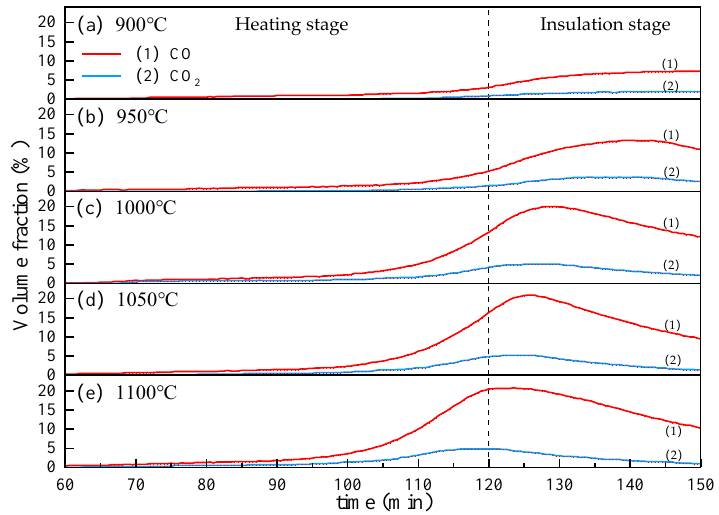
Figure 10. The effect of temperature on the CO and CO 2 contents in the off-gas.